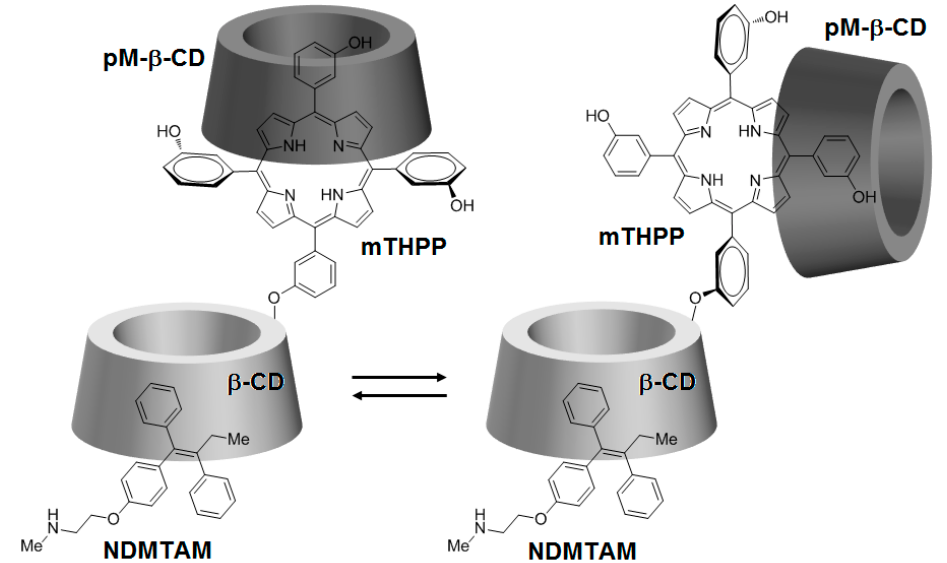
Figure 29. Solution structure of mTHPP- β -CD/pM- β -CD/ N -desmethyltamoxifen (NDMTAM) as a 1:1 mixture of diastereoisomeric complexes, as derived from NMR spectroscopic data. Adapted from Theodossiou; Goncalves; Yannakopoulou; Skarpen; Berg [146].